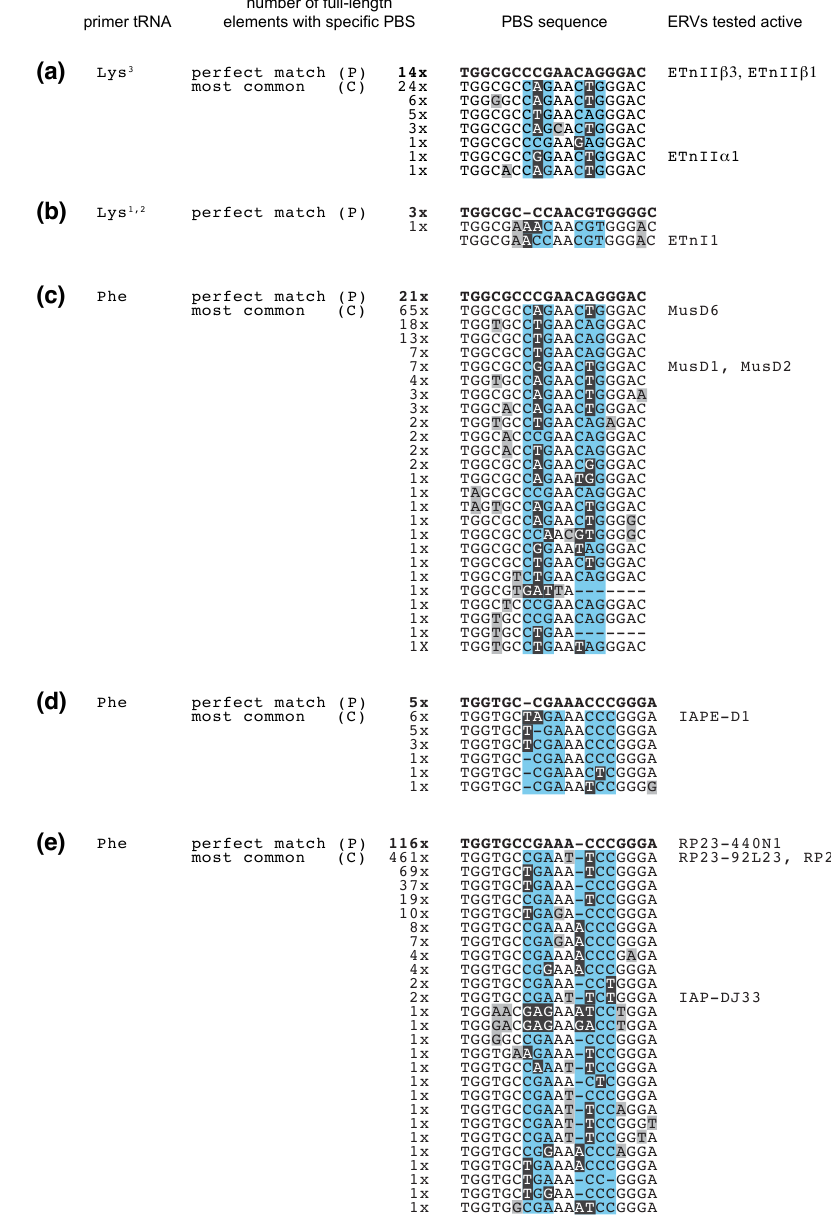
Figure 2. Sequence variation in the 18 nucleotide tRNA primer binding site (PBS) of the murine endogenous retroviruses (ERVs) ( a ) ETnIIbeta (tRNA Lys3 ), ( b ) ETnIIbeta (tRNA Lys1,2 ), ( c ) MusD (tRNA Lys3 ), ( d ) IAPE (tRNA Phe ), and ( e ) IAP (tRNA Phe ). The PBS sequences with perfect complementarity to their tRNA primer are at the top of each alignment, bold and marked with a “P”. Numbers indicate how many full-length elements of that particular family in the mouse genome (mm10) had a specific PBS sequence. The most common PBS sequences are denoted “C”, and PBS sequences below are descending to less frequent variations. "Perfect" and "Common" PBS sequences are highlighted in the phylogenetic trees in Figures S1 and S2. Mismatches with the tRNA sequence are shaded in grey and black. Blue shaded nucleotide positions have been tolerant for mismatches when tested for the human immunodeficiency virus (HIV)-1, which uses tRNA Lysine 3 to prime reverse transcription [138]. ERVs that were active in retrotransposition assays are denoted with their names on the right, next to their respective PBS sequence